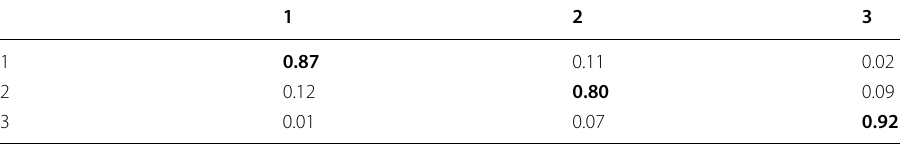
Highest row values are highlighted in